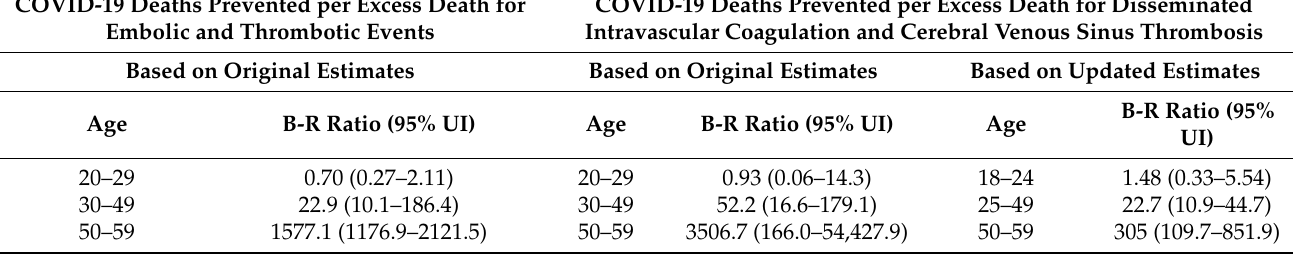
Table 2. Estimated benefit–risk [B-R] ratio of ChAdOx1 nCoV-19 vaccination. COVID-19 Deaths Prevented per Excess Death for COVID-19 Deaths Prevented per Excess Death for Disseminated Embolic and Thrombotic Events Intravascular Coagulation and Cerebral Venous Sinus Thrombosis Based on Original Estimates Based on Original Estimates Based on Updated